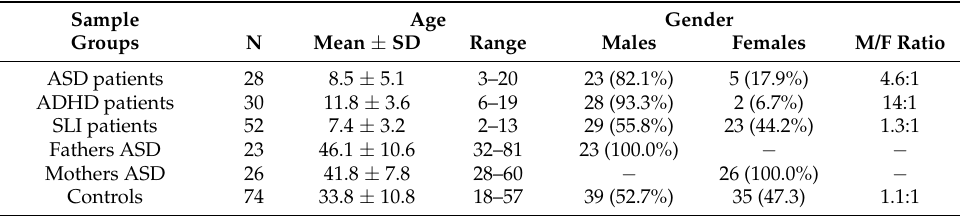
Table 1. Demographic characteristic of all of the analyzed samples (total N = 233